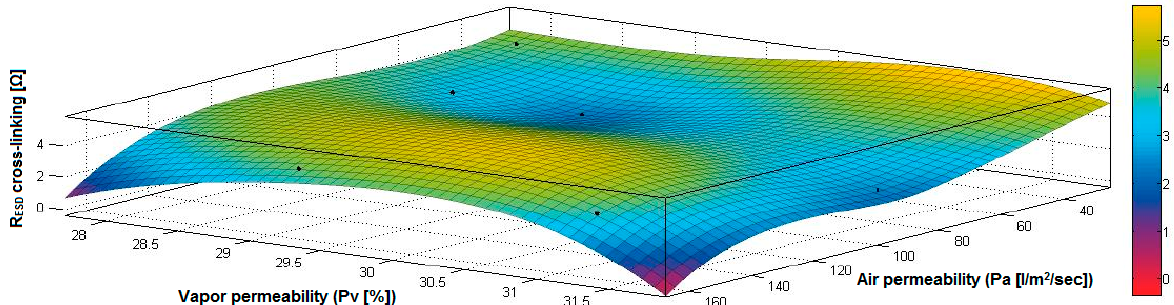
Figure 41. 3D representation R ESD after crosslinking = f(Pa, Pv) samples preliminarily treated in RF plasma O 2 using RF 2 generator and power 50 W.